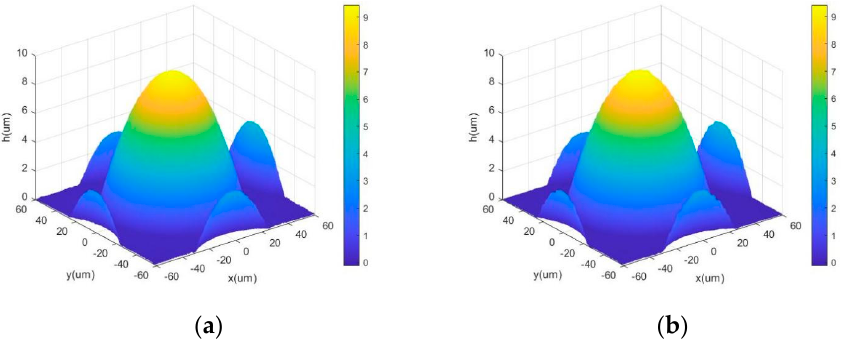
Figure 6. Microlens array: reconstructed image of ( a ) bright-field and ( b ) dark-field IDFDHM .